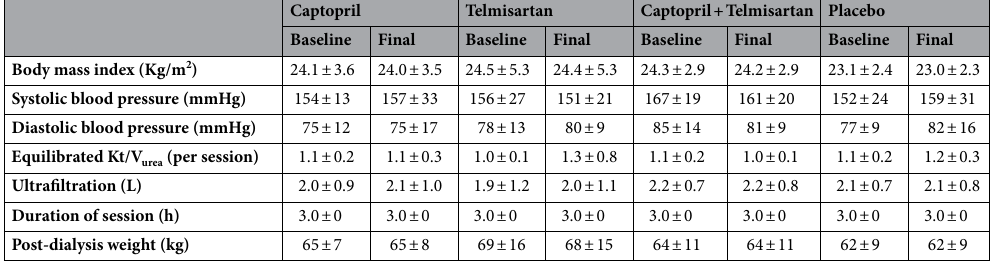
Table 2. Comparison of clinical and dialysis-related variables between groups at the beginning and the end of the study.